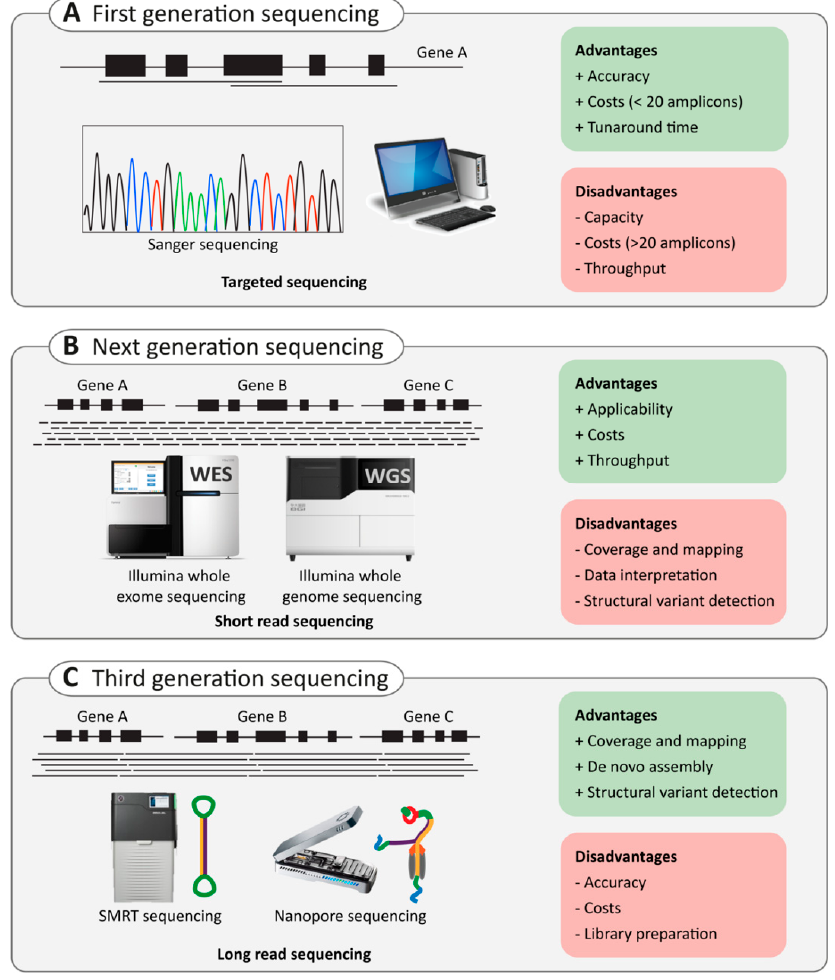
Figure 3. Comparison of conventional Sanger, next-generation, and third-generation sequencing. ( A ) schematic representation of ( A ) first generation sequencing (Sanger sequencing), ( B ) next gen- eration sequencing (e.g. Illumina whole-genome sequencing (WGS) and whole-exome sequencing (WES)) and ( C ) third-generation sequencing (e.g. SMRT sequencing as performed by Pacific Bio- sciences (PacBio) and nanopore sequencing by Oxford Nanopore Technologies (ONT)). For each technique, advantages (green) and disadvantages (red) are provided.